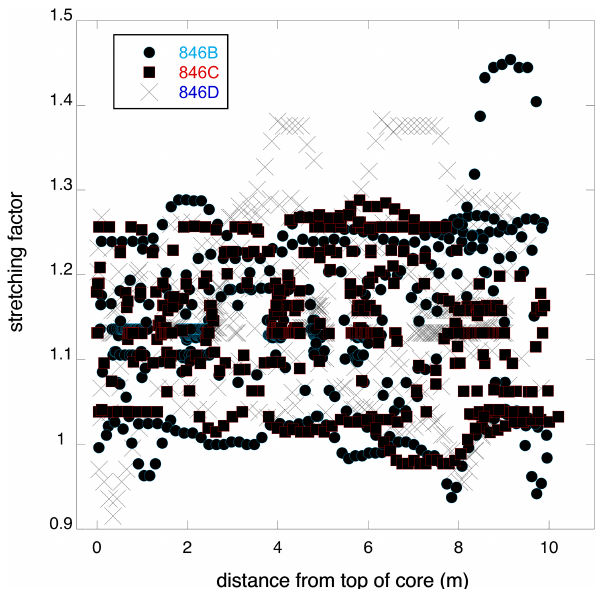
Figure 5. Inferred coring distortion based on Match alignment of GRAPE composite sections to the borehole conductivity log as a function of depth in each ∼ 9 . 5m core. Note that there is no evi- dence for a systematic pattern of stretching and/or squeezing as a function of penetration